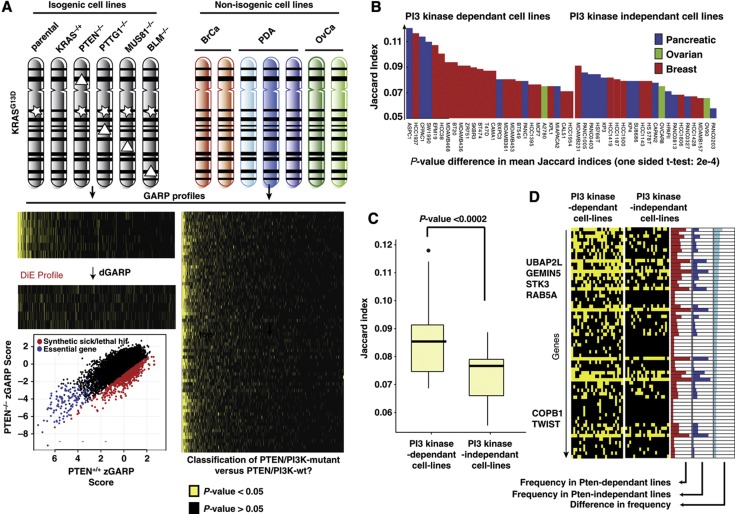
Inferring genetic dependencies on variable cancer genotypes. (A) Schematic outline showing GARP profiles derived from isogenic cell lines on the left and essential gene profile from 72 non-isogenic cell lines on the right. GARP profiles for each cell line, both isogenic and non-isogenic, is represented as sorted dot plots with genes on the x axis and cell lines on the y axis. The yellow dots represent those genes that had a significant GARP score (P-value <0.05). Genes are sorted by their frequency of being essential in the 72 cancer cell lines. The DiE profile contains the significant negative genetic interactions (P-value <0.05, derived as pictured for the PTEN-null case in the lower left box: red dots, synthetic lethal or sick; blue, general essentials; black, not-influenced genes). We model that the enrichment of genes in the DiE profile from the isogenic cell lines will be a key feature in defining the genetic dependencies of the non-isogenic cancer cell lines. (B) Jaccard index (defined as the intersection between the DiE profile of PTEN and the essentials genes (P<0.05) of non-isogenic lines divided by their union) exhibit a higher overlap on average for those lines that are dependent on PTEN/PI3K pathway (shift in mean is significant, P-value <0.002). (C) The Jaccard index distribution for both the PTEN-dependent and PTEN-independent sets are plotted as box plot. Dots are extreme values (outliers; defined as having an Jaccard index more than 3/2 times higher as the upper quartile, which represents 75% of the data), the vertical lines represent the span of maximal to minimal value of non-outliers, the boxes span the upper (75% of the data) to lower (25% of the data) quartiles, the vertical line represents the median. (D) Heat map showing distributions of genes that exhibit negative genetic interaction with PTEN and are at the same time more frequently essential (P<0.05) in the PTEN/PIK3-dependent cell lines compared with PTEN/PI3K-independent lines. Red color histogram shows the frequency in cell lines that are PTEN/PI3K dependent, blue represents the PTEN/PI3K-independent cell lines. Light blue bars give the difference in frequency between the two sets according to which the heat map is sorted (only genes with a difference in frequency >0.1 and more frequent in PTEN/PIK3-dependent cell lines are shown).